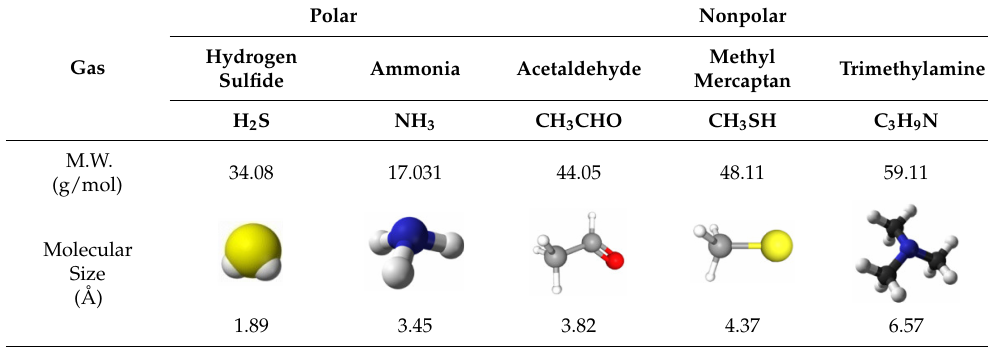
Table 3. Textural properties of exhaust gases from medical